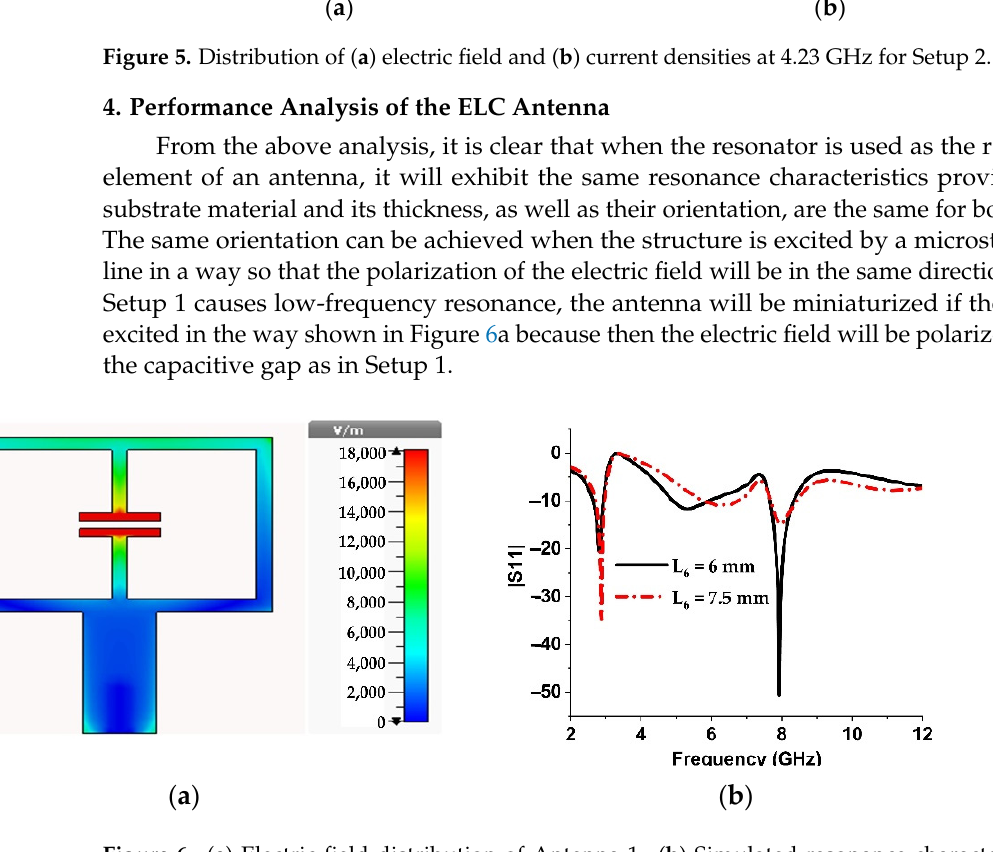
Figure 6. ( a ) Electric field distribution of Antenna 1. ( b ) Simulated resonance characteristics of Antenna 1 for different ground plane sizes.